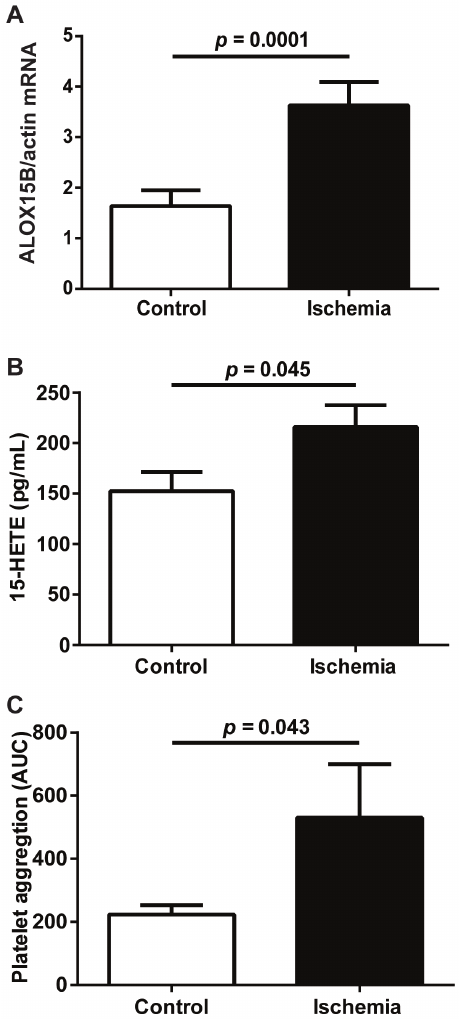
Figure 3. Platelet aggregation is increased by incubation with lysates from human ischemic macrophages. (A) ALOX15B mRNA expression in primary human monocyte-derived macrophages incubat- ed in control (21% oxygen) and ischemic (1% oxygen) conditions. ( B ) 15-HETE production in cell lysates from macrophages incubated in control and ischemic conditions. ( C ) Area under the curve (AUC) of platelet aggregation measured using cell lysates from control and ischemic macrophages. Data are mean 6 SEM from 4 independent experiments (i.e. macrophages from 4 blood donors) analyzed in